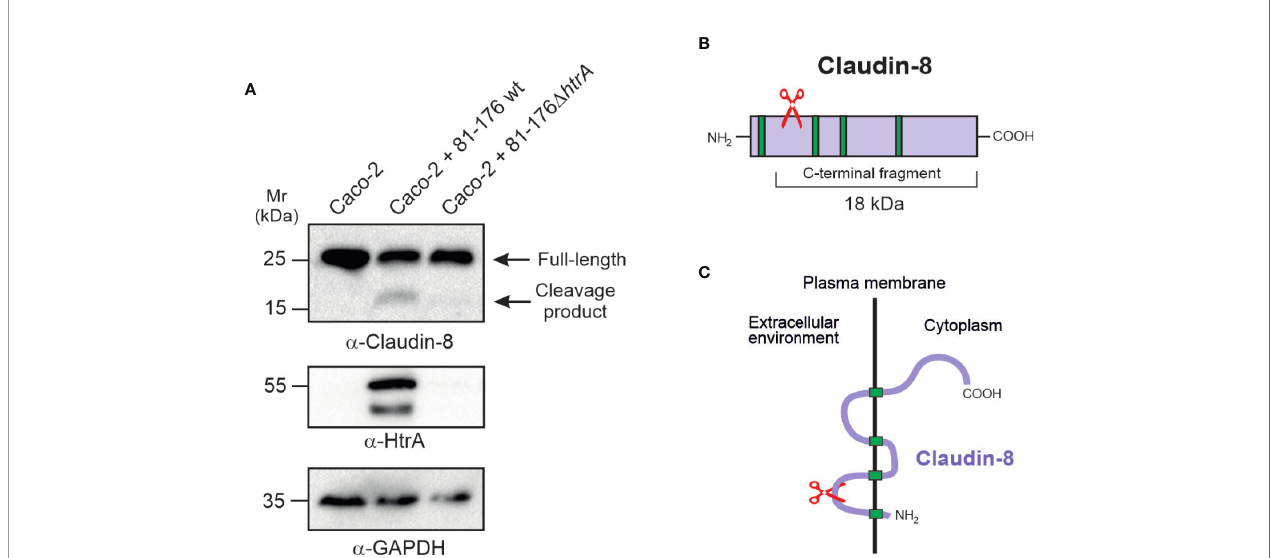
FIGURE 4 | HtrA cleaves claudin-8 during C. jejuni infection in vivo . (A) Immunoblotting of protein extracts from polarized Caco-2 cell monolayers infected with C. jejuni wild-type (wt) or D htrA mutant. The blots were stained with polyclonal a -claudin-8 antibodies recognizing the carboxy-terminus of the protein. The a -HtrA and a -GAPDH blots served as controls. Besides the full-length protein (~26 kDa), a cleaved carboxy-terminal fragment (~18 kDa) was visualized with a - claudin-8 antibodies upon infection with C. jejuni wt. (B) Proposed cleavage site position in the amino-terminus of claudin-8 for HtrA protease according to the size of protein cleavage products determined by SDS-PAGE marker proteins. (C) A model for claudin-8 cleavage in the fi rst extracellular loop (ECL1) by HtrA